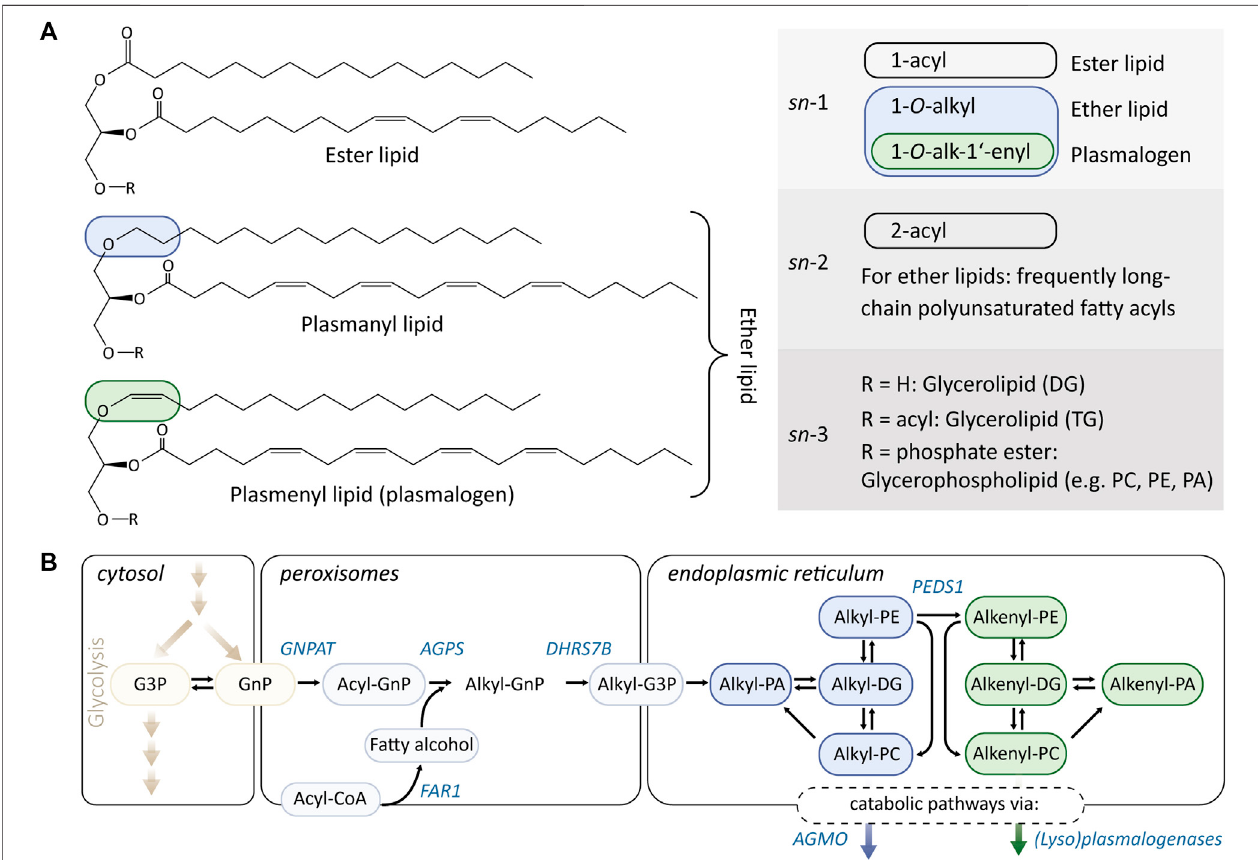
FIGURE1|(A) Overview ofthechemicalstructuresanduniquefeaturesofdiacyl (ester) lipids, and plasmanyl and plasmenyl lipids. Ether lipidscompriselipids that harbor both alkyl (1- O -alkyl, plasmanyl, indicated in blue) and alkenyl (1- O -alk-1 ′ -enyl, plasmenyl, indicated in green) residues, while the latter is also referred to as plasmalogens. Thealkyl/alkenyl residues ofmammalianetherlipids are predominantly localized at the sn -1position, while the sn -2position isfrequentlysubstituted with polyunsaturatedfattyacyls.Etherlipidsbelongforthemostparttothelipidclassesphosphatidylethanolamines(PEs),phosphatidylcholines(PCs),and1- O -alkyl-2- acylglycerols (alkyl-DG). (B) Ether lipid metabolism. The initial steps of ether lipid biosynthesis take place in the peroxisomes and are based on substrates derived from glycolysis and fatty acid metabolism. The rate-determining step is the provision of fatty alcohols, which are formed from acyl-CoA by fatty acid reductase 1 (FAR1). Remodeling/interconversion pathways of ether lipids are partially shared with their ester lipid analogs. The enzyme plasmanylethanolamine desaturase (PEDS1) is responsible for converting plasmanyl lipids (blue) into their plasmenyl counterparts (green) and accepts PE as substrates. The catabolism of ether lipids proceeds from their lyso-forms and is catalyzed by alkylglycerol monooxygenase (AGMO; in the case of plasmanyl lipids) and (lyso)plasmalogenases (in the case of plasmenyl lipids).